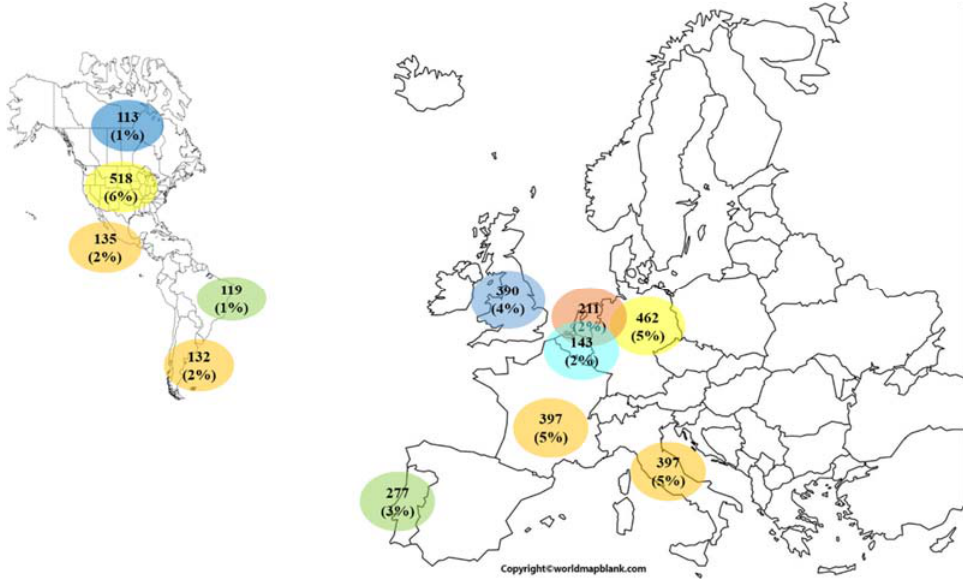
Figure 6. Top most collaborative countries with Spanish institutions worldwide. Table 4. List of 10 most prolific authors with their affiliation and relevance in the period 1960–2021 analyzed the present non-exhaustive overview performed in this